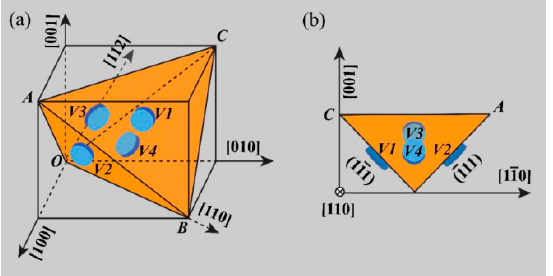
Figure 8. Schematic illustrations showing four types of η variants V1-4 on {111} Al ( a ) The three-di- mensional view, and ( b ) the projection from {110} Al direction. Adapted with permission from ref. [55]. 2021 Zang et al.